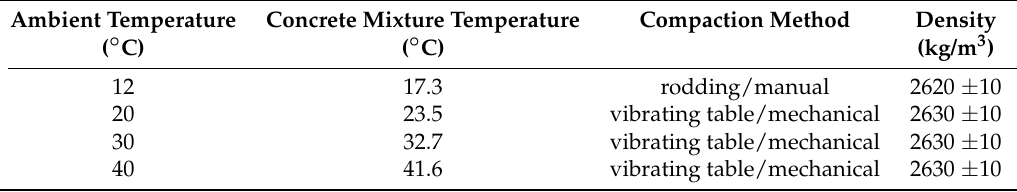
Table 5. Temperature influence on the density of the concrete